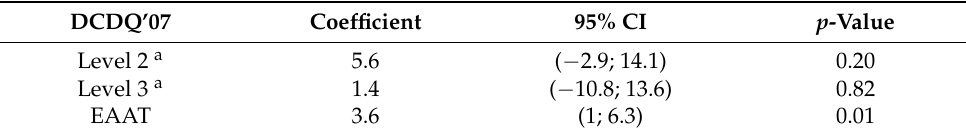
Table 3. Association between the EAAT and the DCDQ’07.